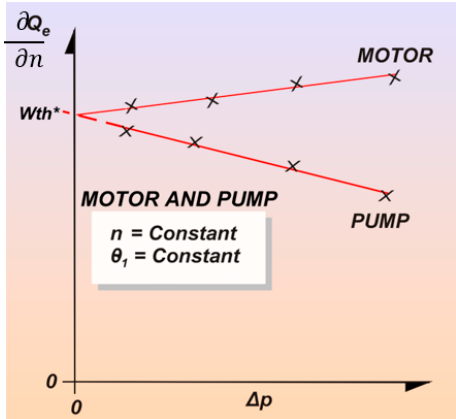
Figure 9. Determination of theoretical displacement, 𝑊 𝑡ℎ∗ , and axial piston motor at ( a ) 35 ° C, ( b ) 41 ° C, ( c ) 50 ° C, ( d ) 56 ° C, and ( e ) 67 ° C.